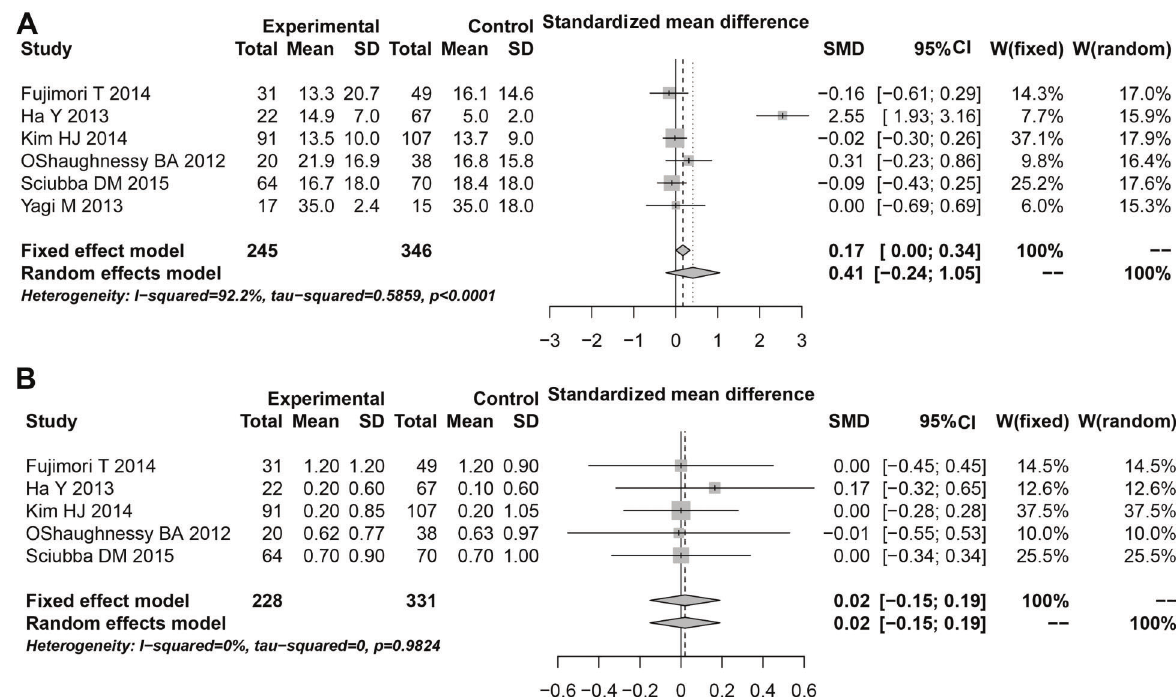
Figure 2. Forest plots for Oswestry disability index ( A ) and Scoliosis Research Society (SRS) function subscores ( B ). UT (experimental group): upper thoracic; LT (control group): lower thoracic. See Table 1 for reference numbers of cited